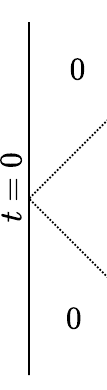
Figure 2 . The linearized solution δ g φ = δφ R − δφ A as a function of space and time. The dotted lines indicate the locations of the shockwaves which restore the boundary